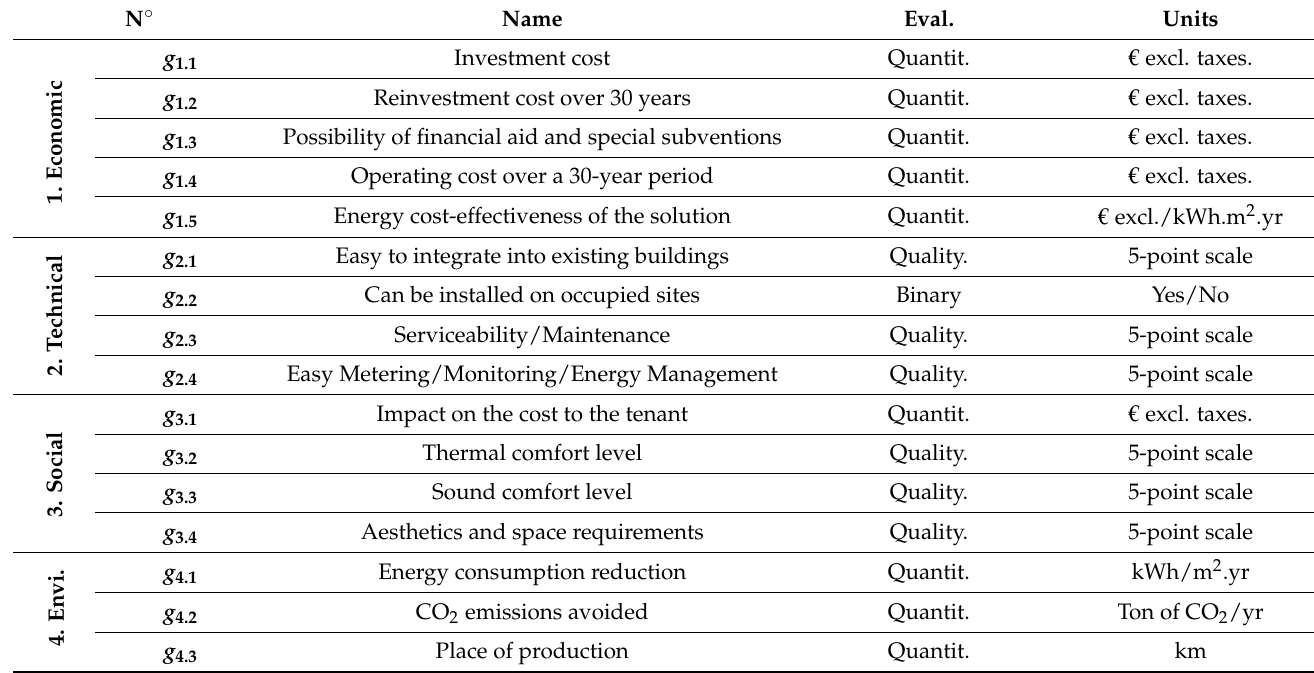
Table 4. Assessment criteria.